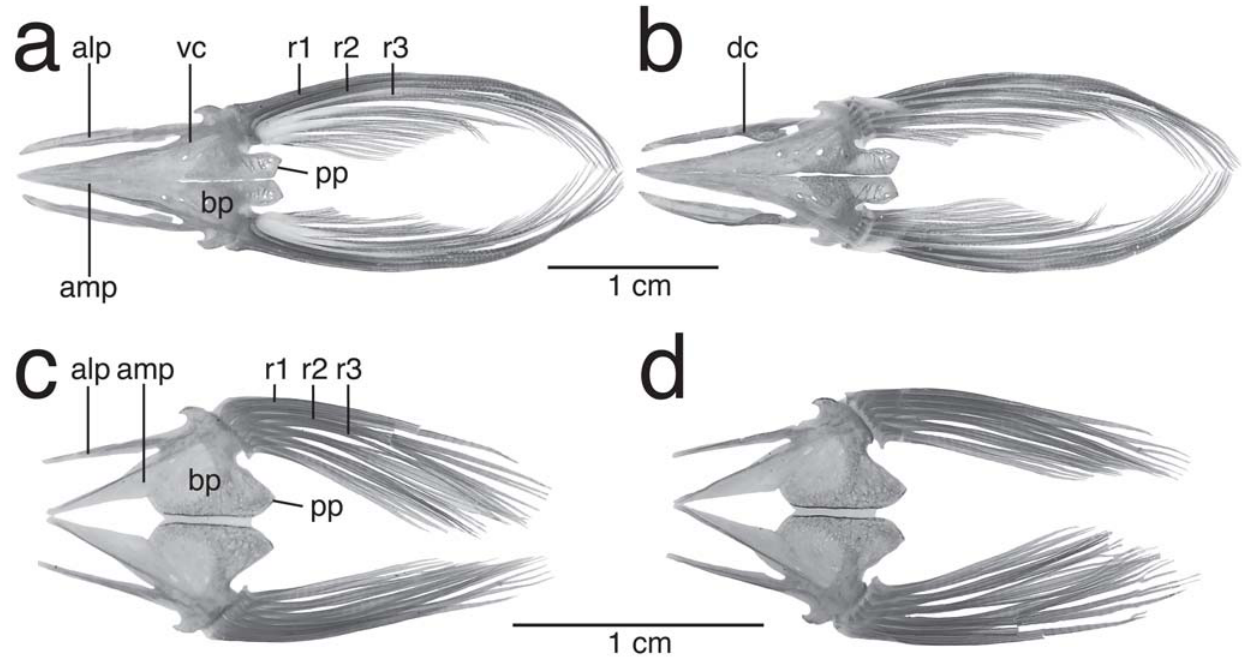
Fig. 2. Pelvic fins and basipterygia in Megalonema orixanthum , ANSP 187450, a , ventral view, b , dorsal view, and M. platycephalum , ANSP 189040, c , ventral view, d , dorsal view. alp = anterolateral process; amp = anteromedial process; bp = basal plate; dc = dorsal crest; pp = posterior process; r1-3 = pelvic-fin rays; vc = ventral posterior to vertical through tips of adpressed anal- fin rays; eye small, horizontal diameter contained 5-6 times in head length; pectoral spine with numerous, erect dentations along posterior margin; premaxillary tooth band broad with about 8-10 rows of teeth; 18- 20 gill rakers on first arch. Magdalena River Basin